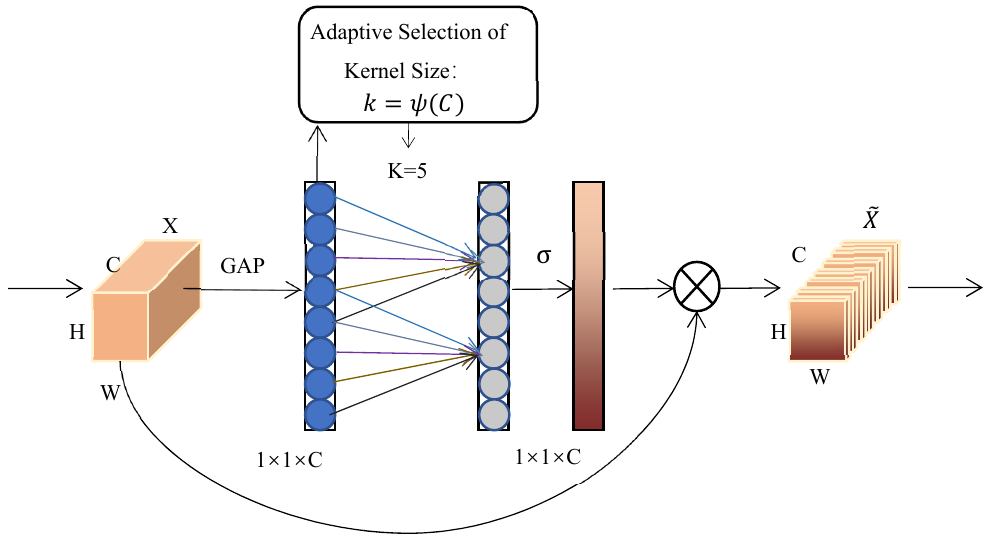
Figure 4. Diagram of the efficient channel attention (ECA) block.